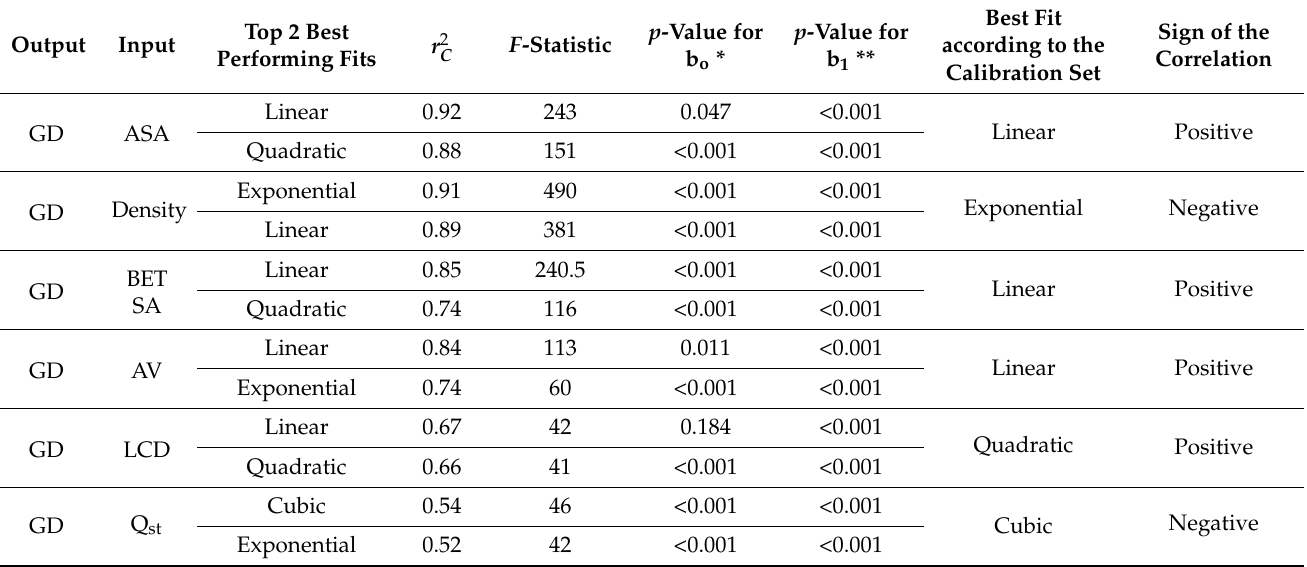
Table 4. The best fits of the six selected input variables depicting the material, pore, and thermodynamic properties from the SLR models.